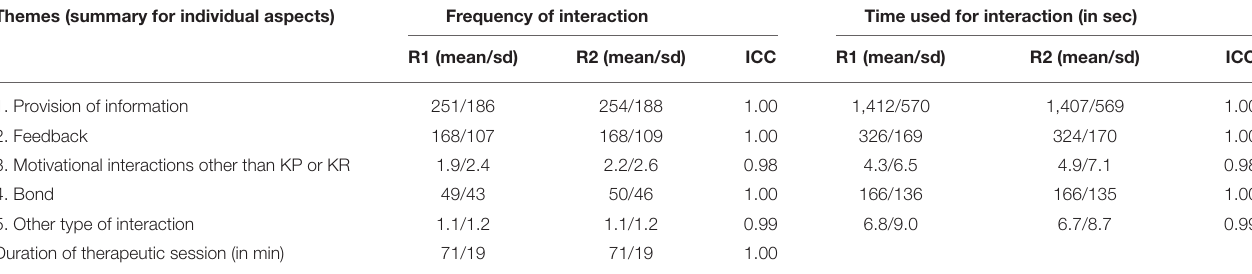
TABLE 4 | THER-I-ACT observations and inter-rater-reliability–summary data ( n = 29). Themes (summary for individual